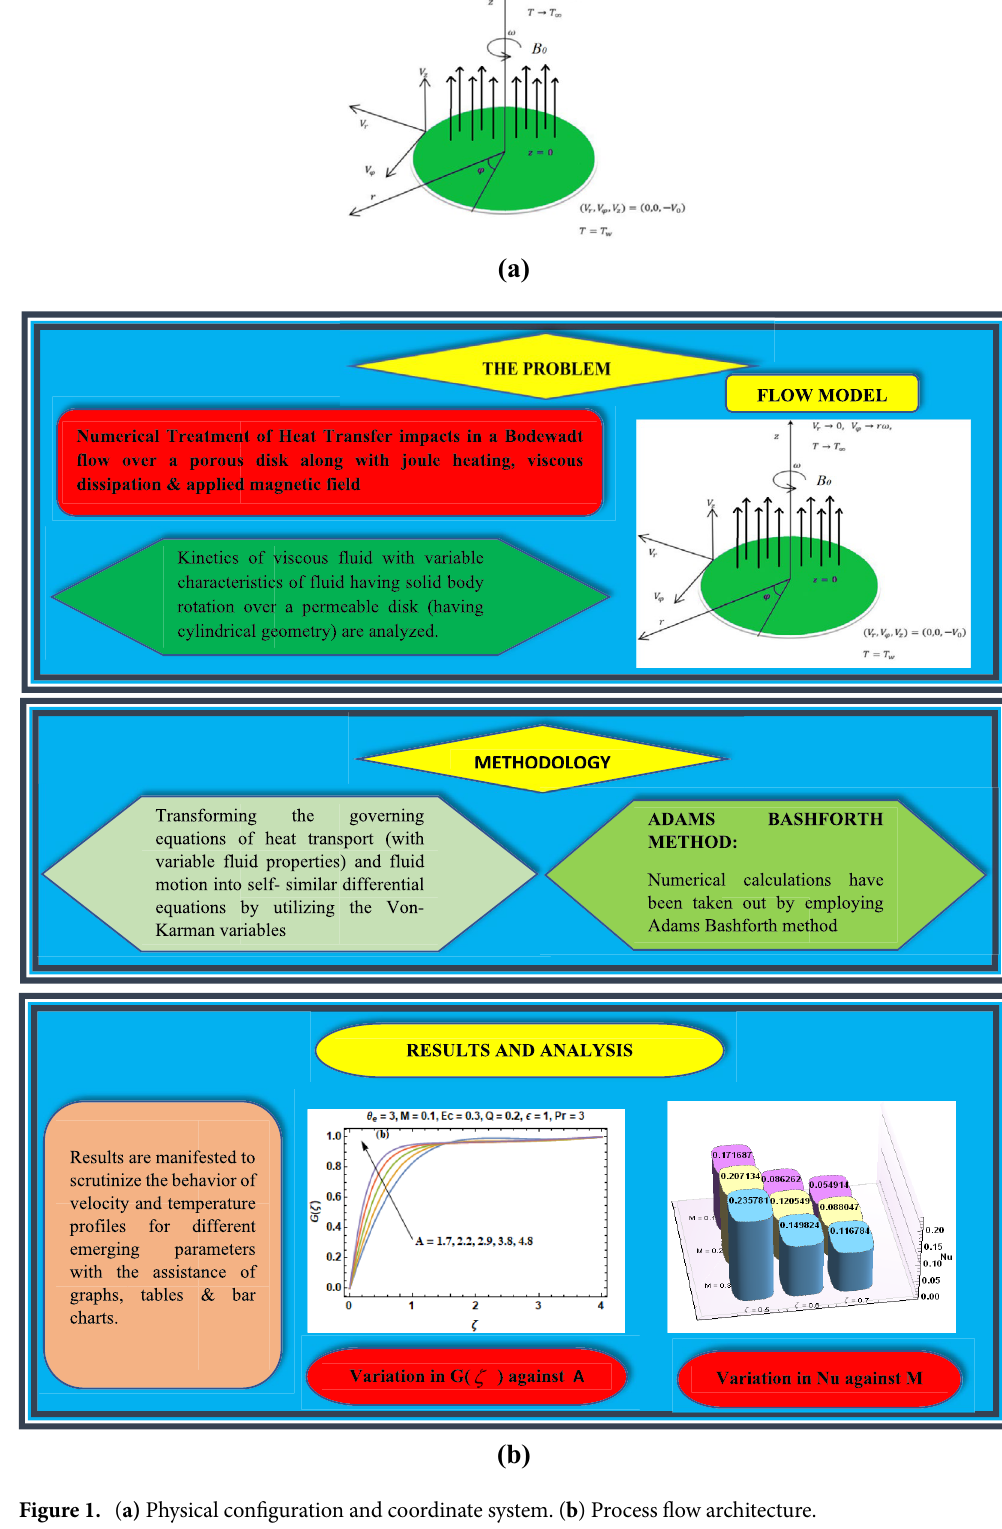
Figure 1. ( a) Physical configuration and coordinate system. ( b ) Process flow